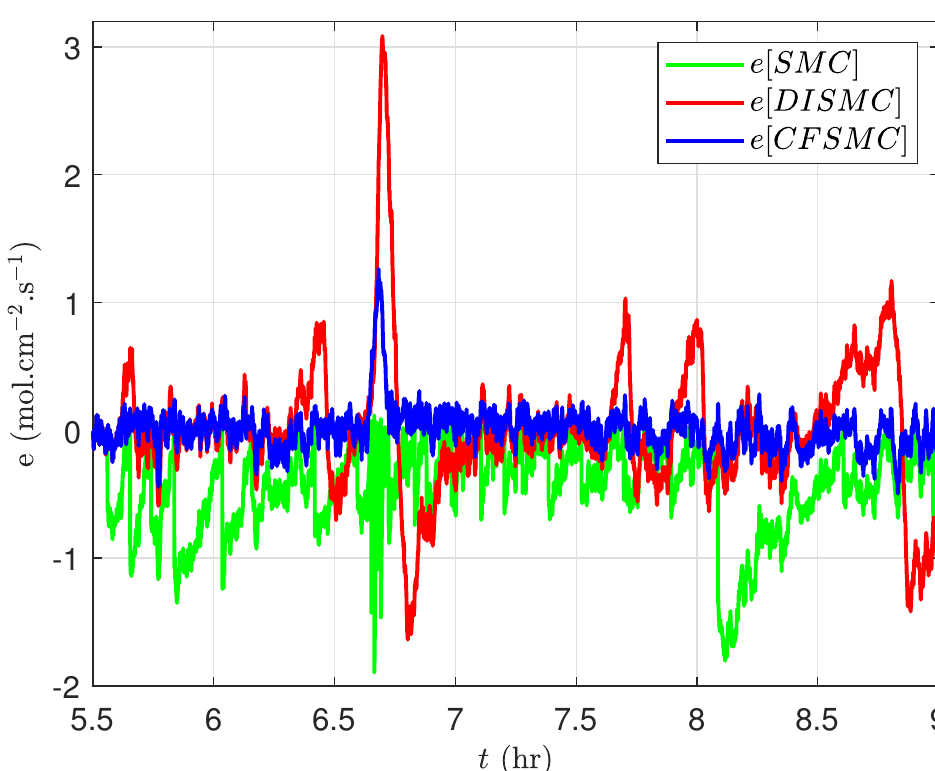
Figure 3. Tracking -error with various controllers during closed-loop operation with